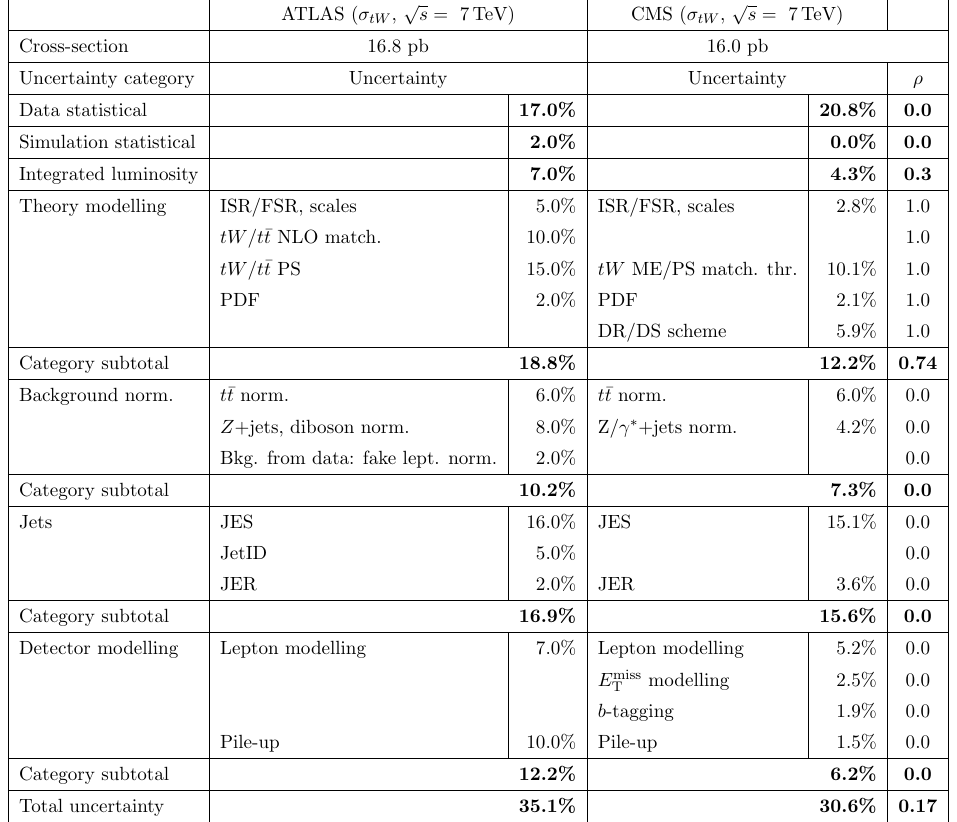
Table 11 . Measured cross-sections, uncertainty components, their magnitudes (relative to the individual measurements) and the correlation ( (cid:26) ) between the ATLAS and CMS (cid:27) tW measurements at p s = 7 TeV. Uncertainties in the same row can be compared between experiments, as detailed in the text. The naming conventions follow those of the corresponding